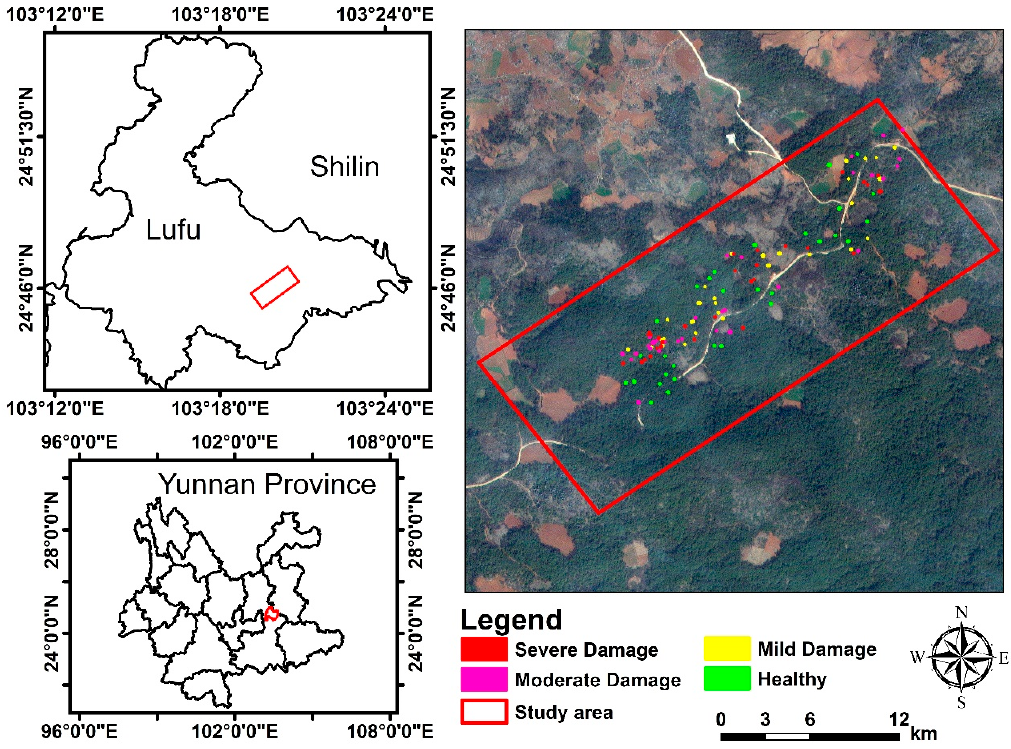
Figure 1. Our study area is located in Yunnan,